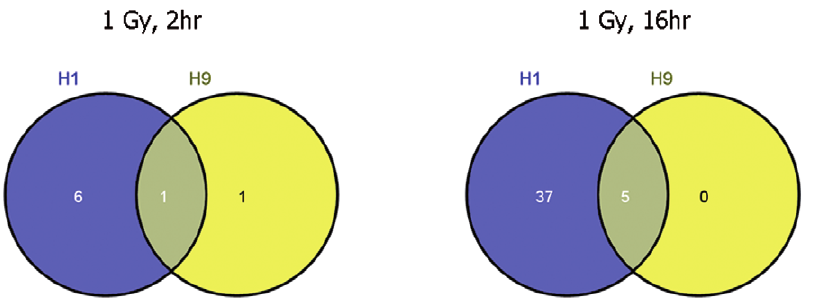
Figure 1. Venn diagrams of significantly upregulated miRNA species in human embryonic stem cells after IR exposures (p , 0.05). Comparison of the dynamics of IR response between H1 and H9 cell lines.